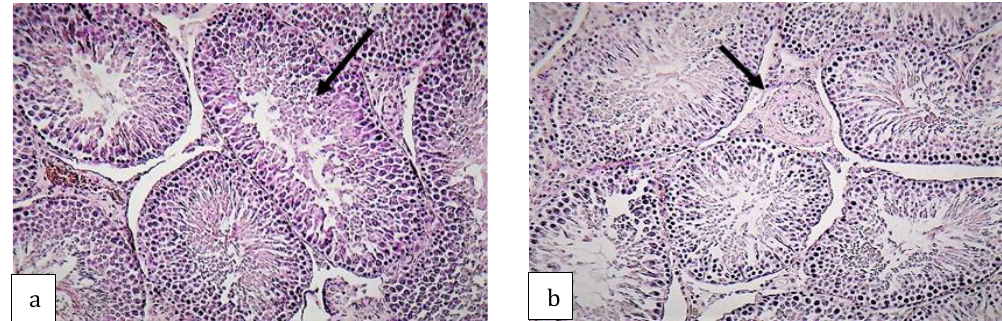
Figure 3. A photomicrograph of the right testis of an adult male Wistar rat received H 2 O 2 (G1) showing a) dissolution of spermatogonial cells as eosinophilia (arrow) and loss of sperms (H&E, 100×), b) hypertrophy of blood vessel (arrow) and contain few inflammatory cells and in interstitial (H&E,